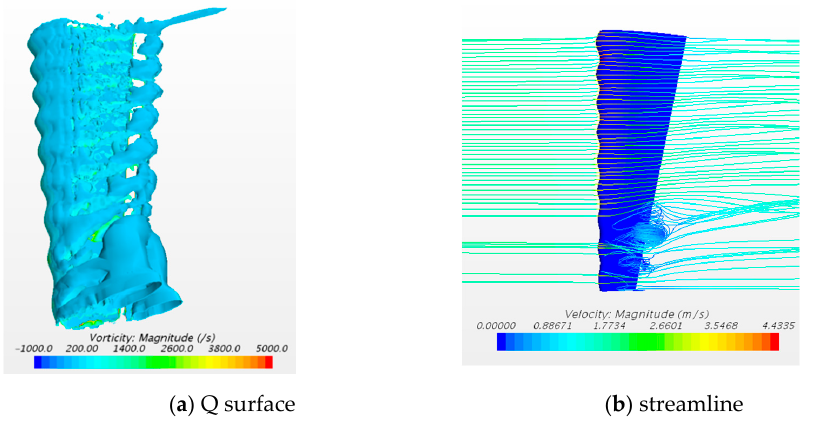
Figure 14. Vortex structures and streamlines near the surface of H5N9 when attack angle is 16° (the iso-surfaces in ( a ) corresponds to Q = 150 and velocity magnitude contour of streamline in ( b )). One may also find from these figures that the vortices near the leading edge of the blade with tubercles become more significant when the height of the tubercle increases.